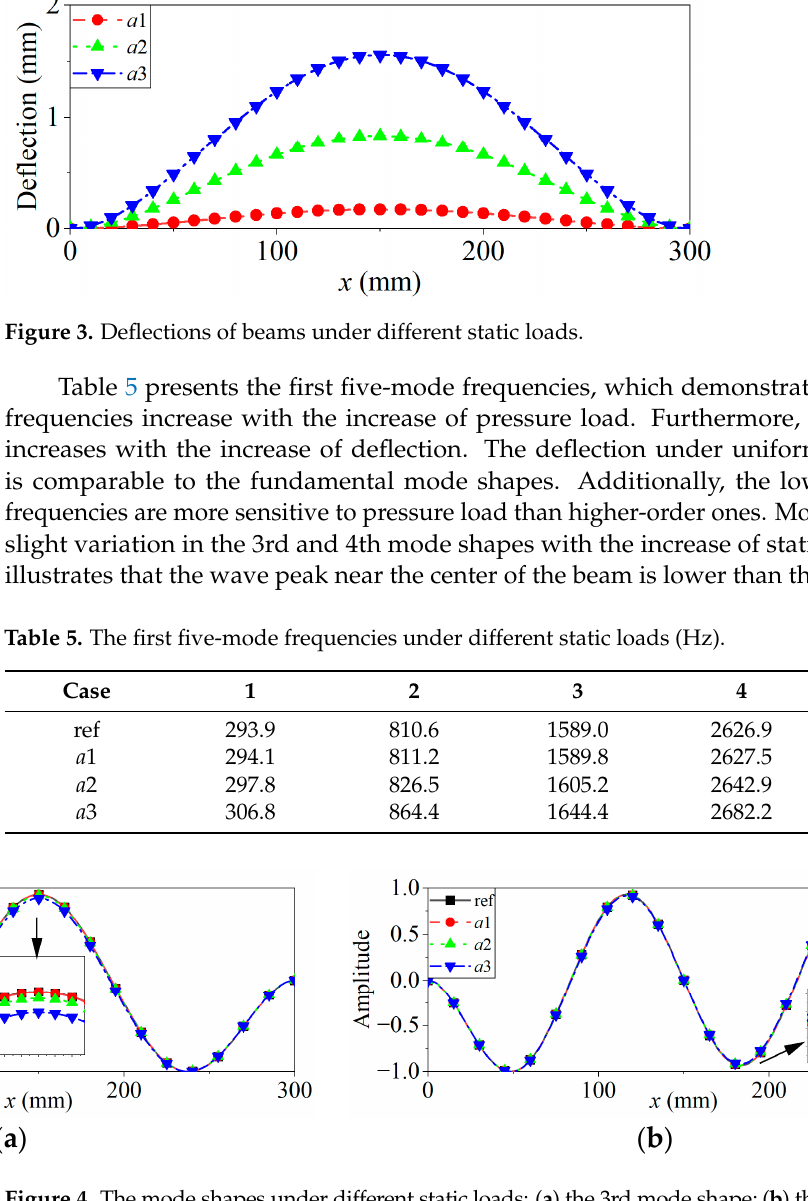
Figure 3. De fl ections of beams under di ff erent static loads.